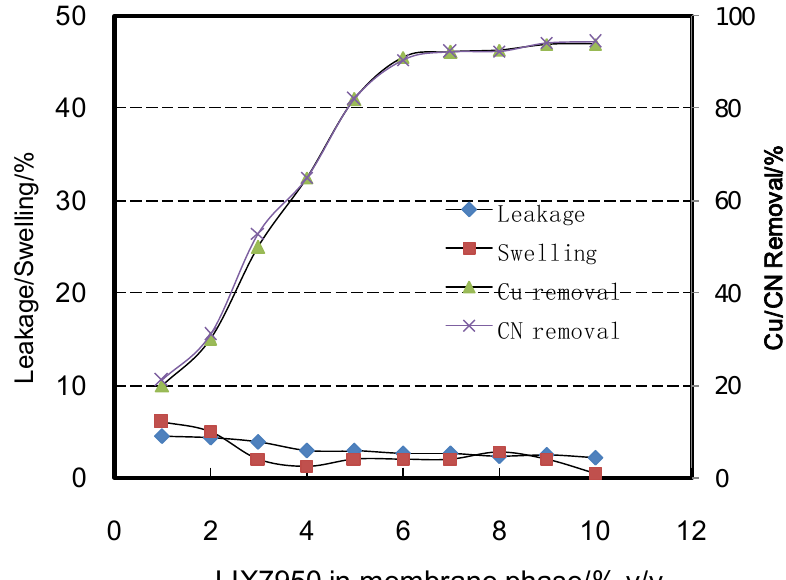
Figure 5. Effect of LIX 7950 concentration on ELM stability and copper and cyanide removal. (For ELMs formation, membrane phase: 2% v / v 1-dodecanol, 5% v / v Span